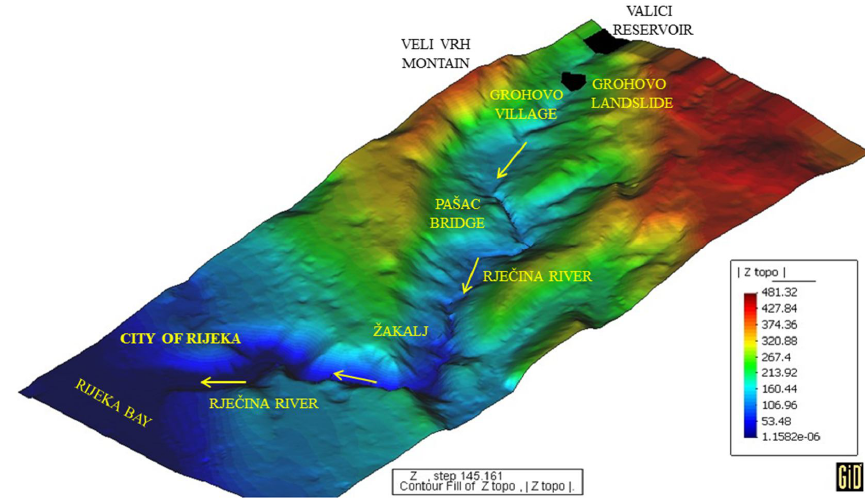
Figure 8. Digital elevation model of the Rje ˇ cina River valley with an SPH mesh, showing natural dam materials and the Vali ´ ci